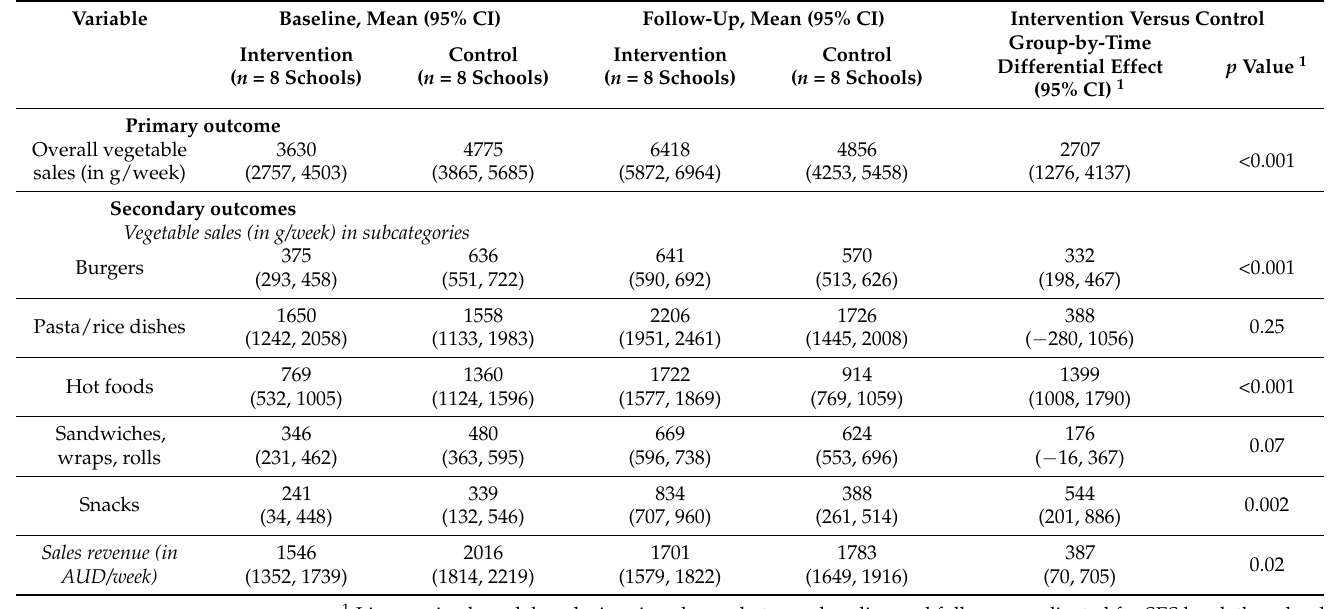
Table 2. Primary and secondary outcomes in the baseline and follow-up period for schools that either implemented the multi-strategy behavioral intervention (intervention schools) or continued to offer their regular canteen menu (control